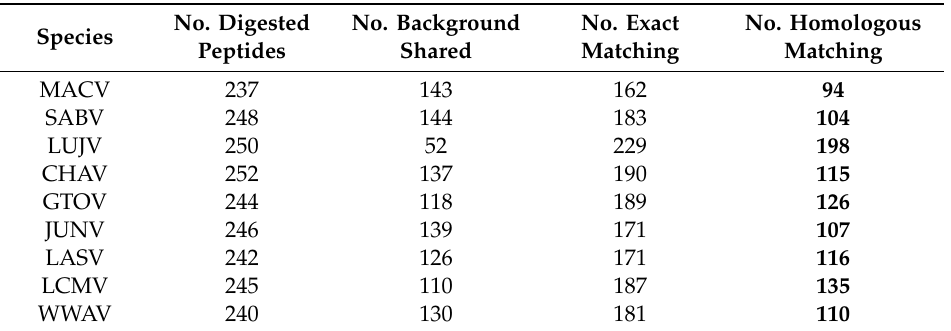
Table 4. This table shows the number of taxon-specific peptides from nine arenavirus species after (i) in silico digest, (ii) exact matching, and (iii) homologous matching (80% background consensus threshold). Each target species was compared against the background of eight remaining arenavirus species proteomes and additionally against all reviewed virus proteomes (from UniProt / Swiss-Prot). The second column provides the number of nonspecific peptides, i.e., the ones being shared with the